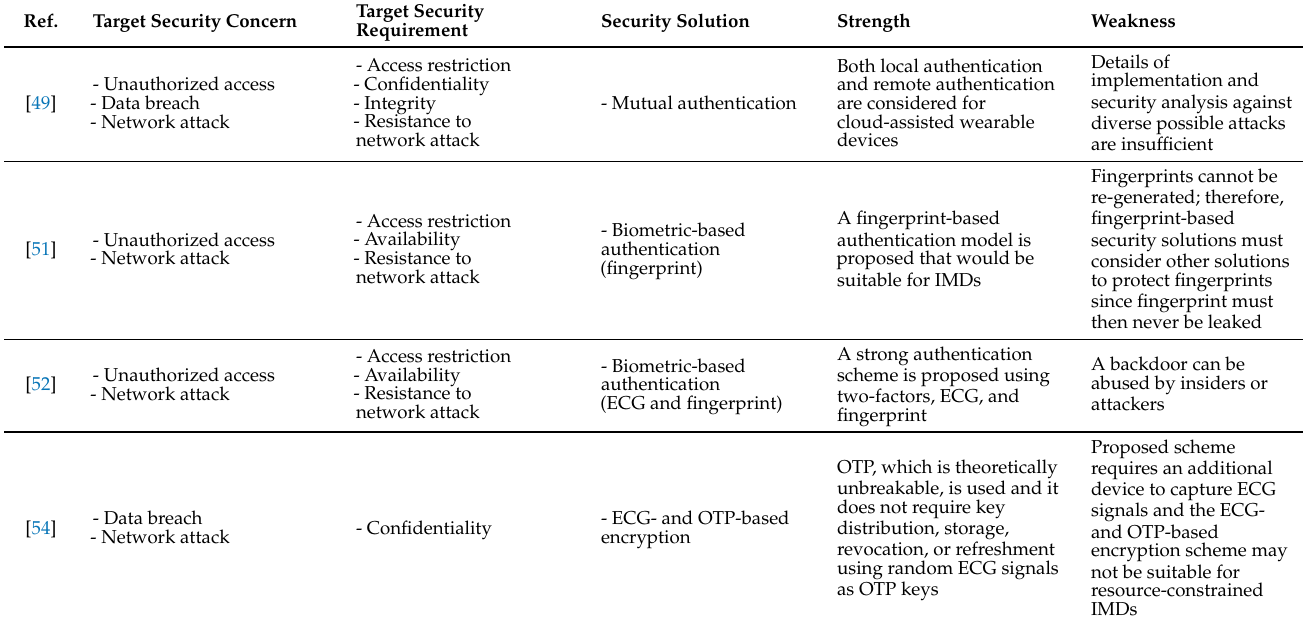
Table 4. Summary for medical device studies on security and privacy.